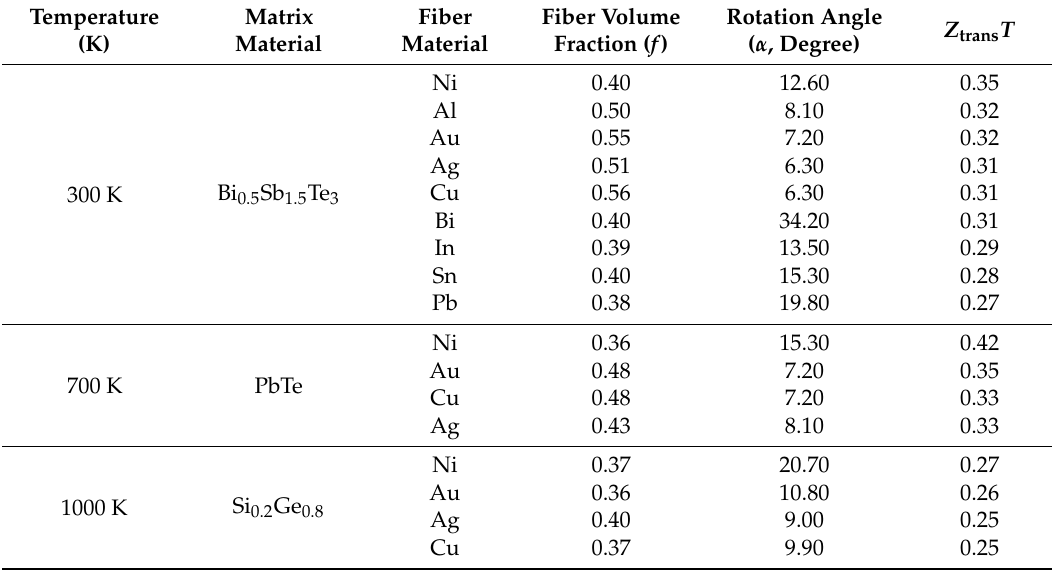
Table 3. Maximum Z trans T values for various combinations of thermoelectric matrices and metal fibers.